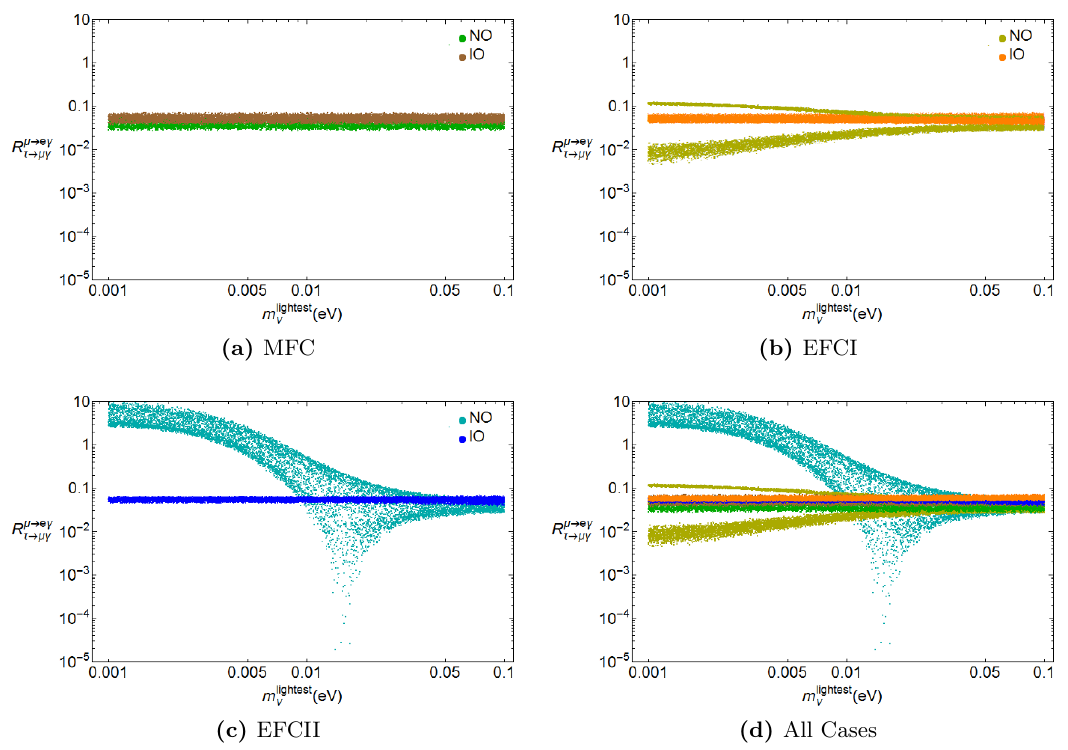
Figure 2. R (cid:22) ! e(cid:13) for the MFC, EFCI and EFCII from upper left to lower left. Lower right reports (cid:28) ! (cid:22)(cid:13) the previous plots altogether. Colour codes can be read directly on each